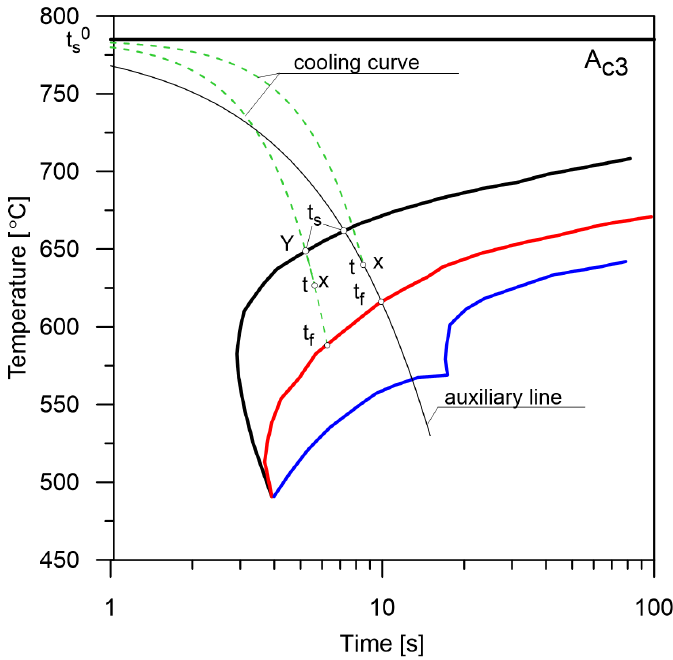
Figure 5. CCT diagram analysis when cooling at different